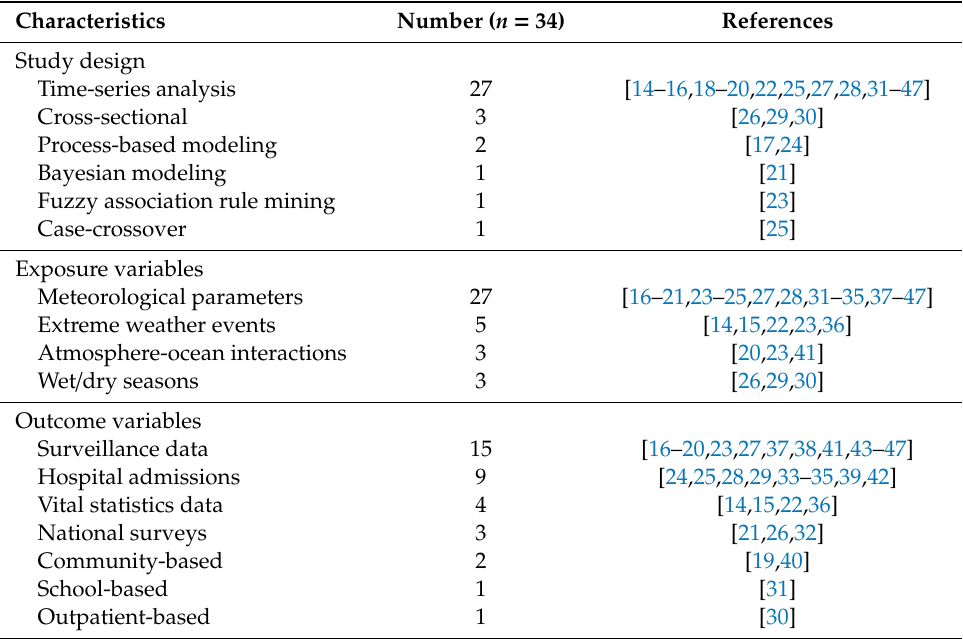
Table 4. Methodological characteristics of selected